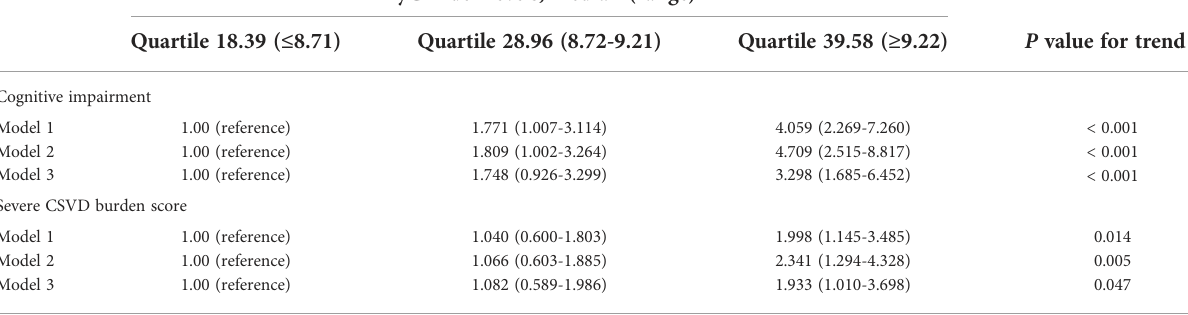
TABLE 4 ORs (and 95% CIs) of cognitive impairment and severe CSVD burden score according to tertiles of TyG index